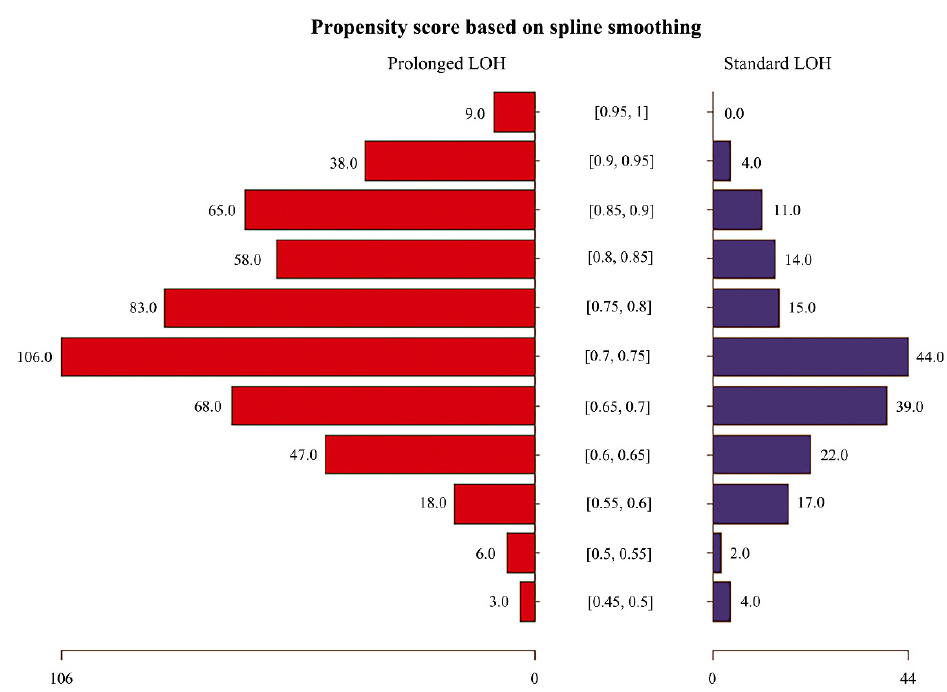
Figure 2. The distribution of propensity scores in the matched cohort.